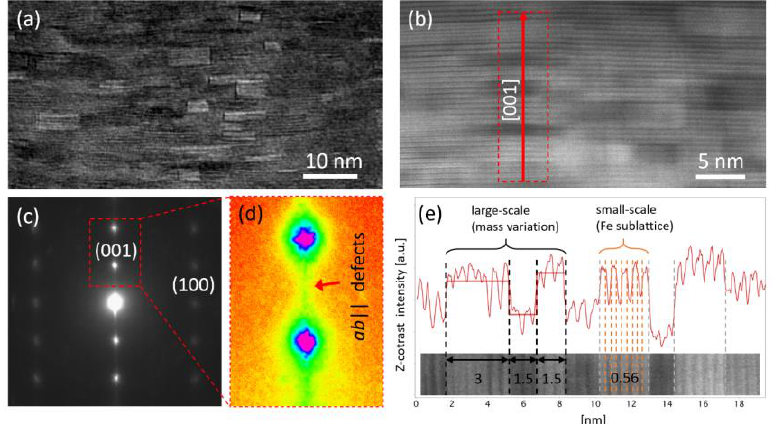
Figure 3. ( a ) Diffraction contrast TEM image; ( b ) STEM Z-contrast image; ( c , d ) SAED image from ( a ); ( e ) Z-contrast intensity profile along the red line marked in ( b ).